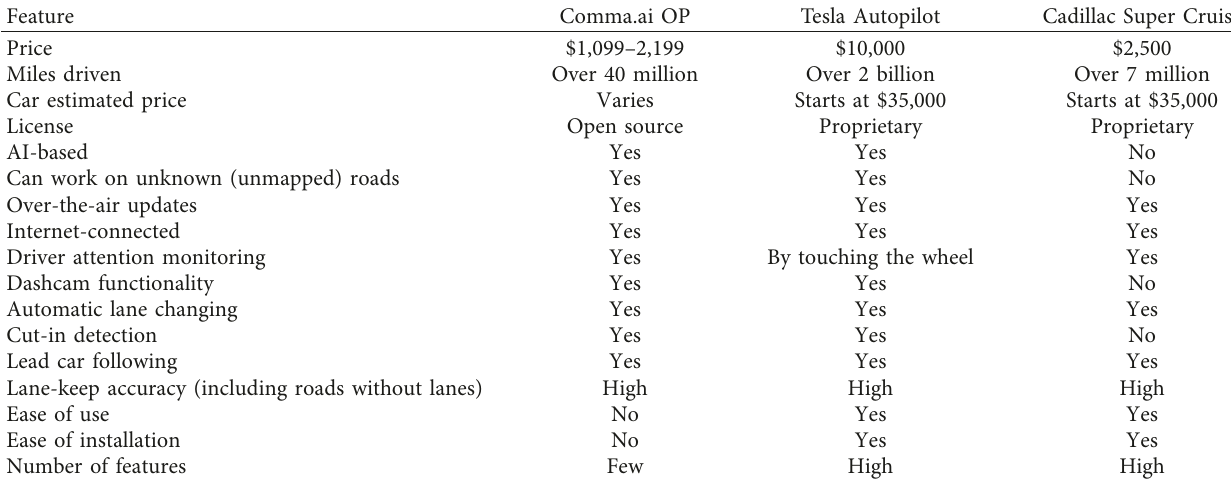
Table 3: Comparison of top self-driving